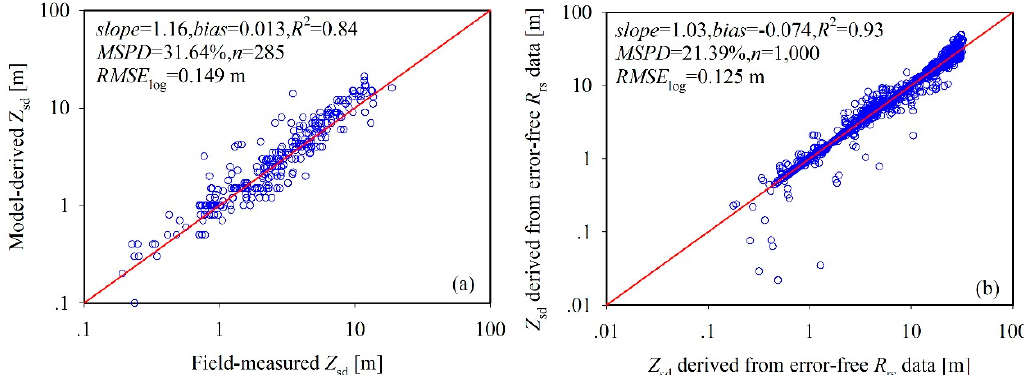
Figure 6. Performance of QAA-based CSSD evaluated using the ( a ) test dataset and ( b ) synthetic dataset in the test 1. As the Hydrolight could not provide the Z sd data, the MSPD and RMSE log values of QAA-based CSSD model in Figure 6b were calculated by comparison of Z sd derived from error-included versus error-free R rs data.